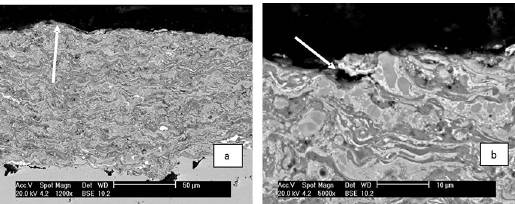
Figure 7. (a) Backscattered electron micrographs showing a nanostructured Cr C -25(Ni20Cr) coated sample that was E-O tested 3 2 at 800ºC (19 m/s, 5 hours). Note that the oxide layer has been almost completely eroded in this region (the arrow indicates some vestiges of the oxide layer); (b) detail of (a) illustrating the erosion mechanism (“micromachining”) on the surface of the nanostructured coating. This indicates that de-cohesion between splats has a considerable influence on erosion of the